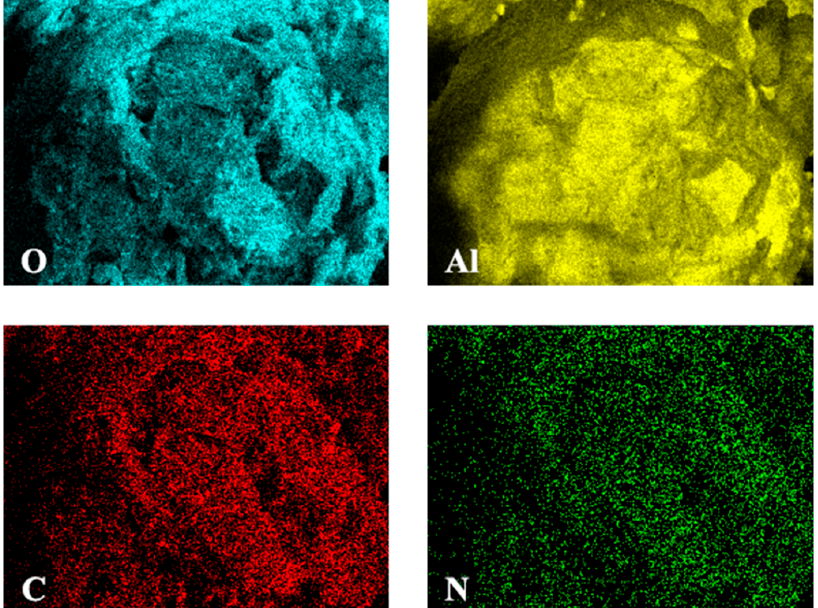
Figure 15. Elemental mapping in the combustion residues of a single Al-Li alloy microparticle.